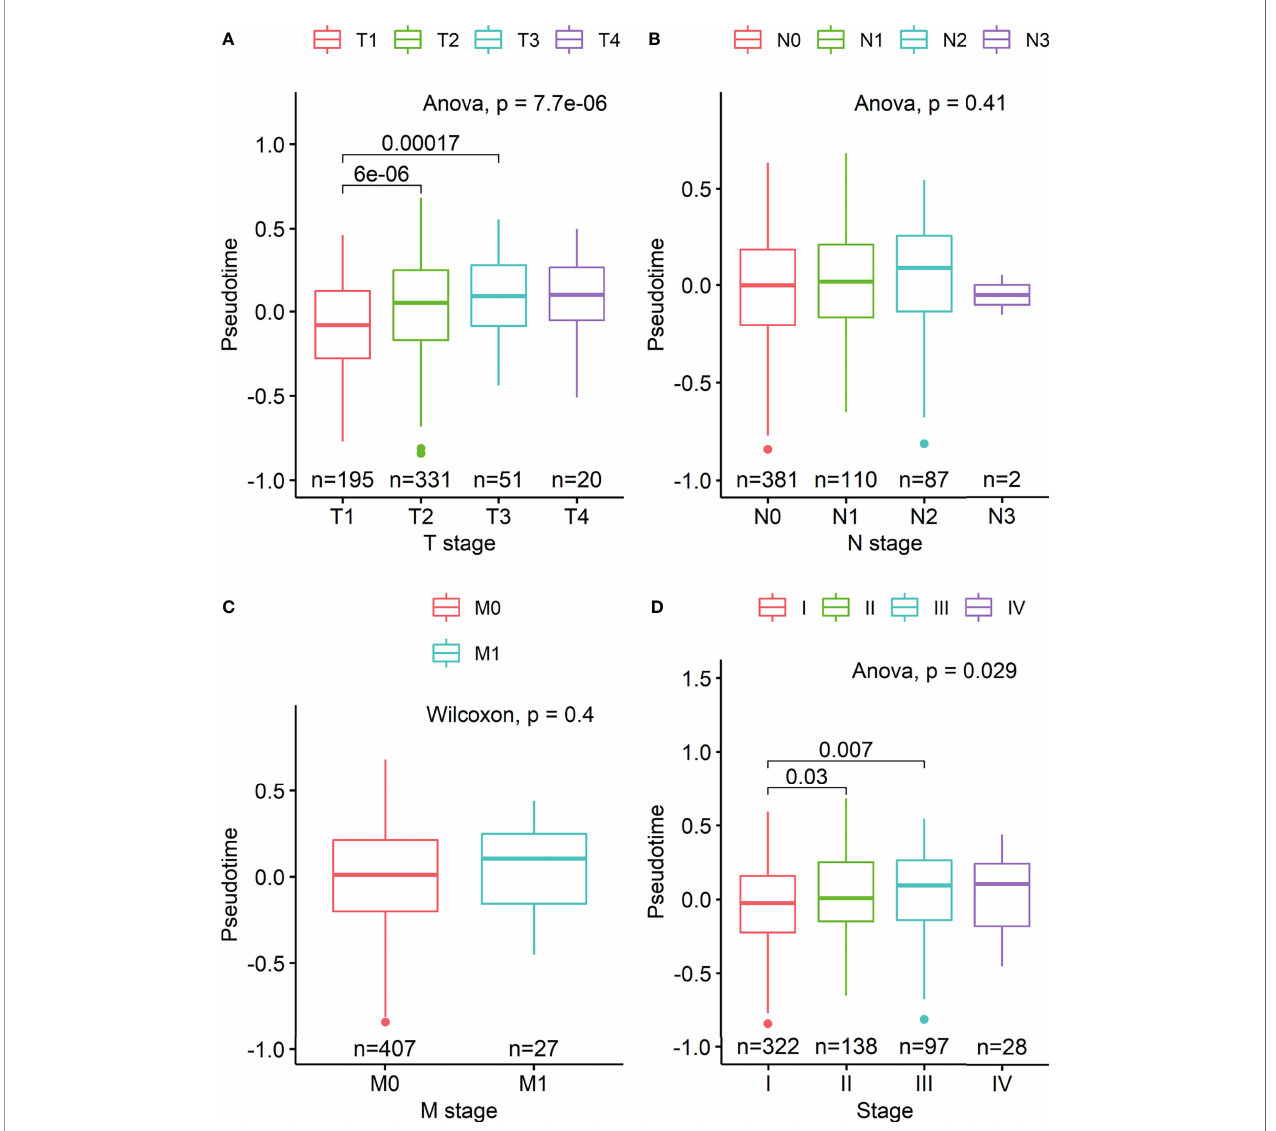
FIGURE 2 | Boxplots visualizing differences in pseudotime according to TNM stage in the TCGA-LUAD dataset. (A) There was a signi fi cant difference in pseudotime in each T stage, especially in T1-T2 (mean: -0.08013 vs. 0.03092, p < 0.001) and T1-T3 (mean: -0.08013 vs. 0.08310, p < 0.001). (B, C) Pseudotime in each N and M stage showed no difference. (D) There was a signi fi cant difference in pseudotime in each overall TNM stage, especially in IA-IB (mean: -0.09326 vs. 0.02969, p < 0.001), IA-IIB (mean: -0.09326 vs. 0.05374, p < 0.001), and IA-IIIA (mean: -0.09326 vs. 0.03749, p <